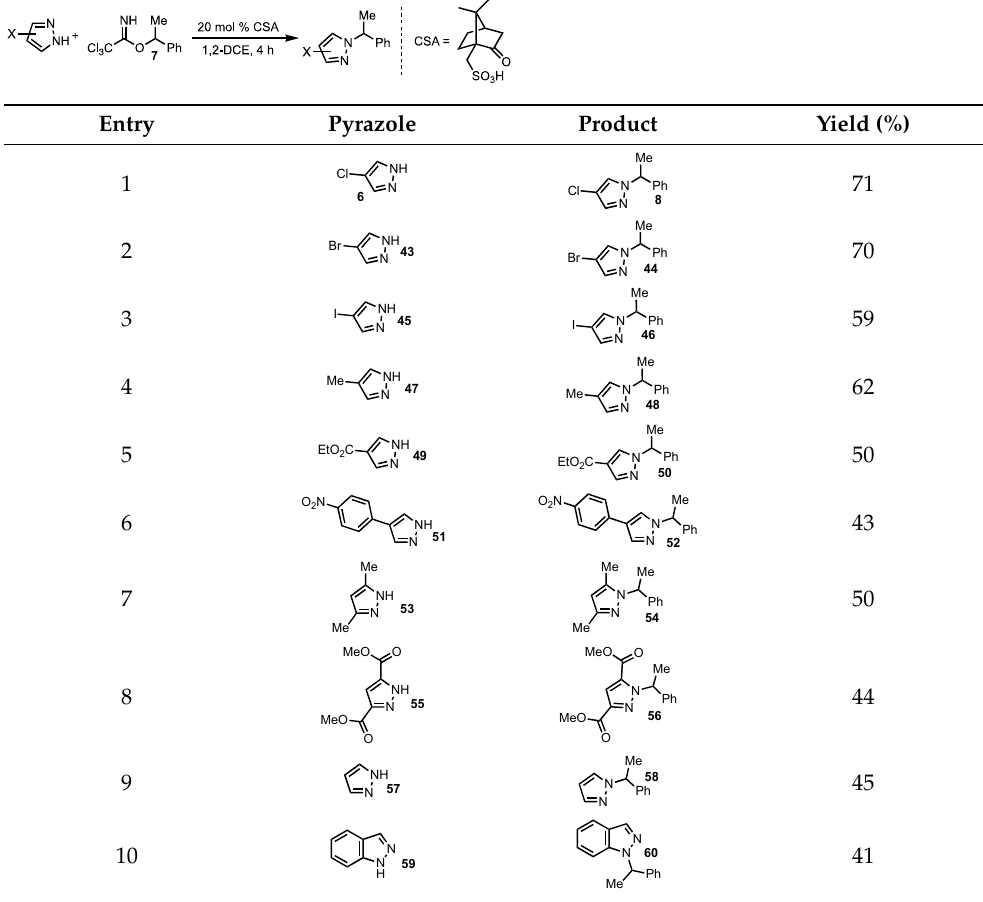
Table 3. Pyrazole alkylations with phenethyl imidate 7 .